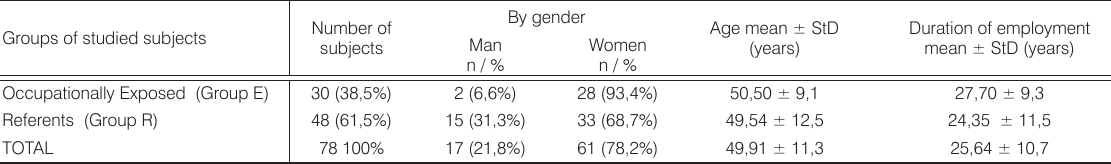
Table 1. General characteristics of studied groups of subjects.